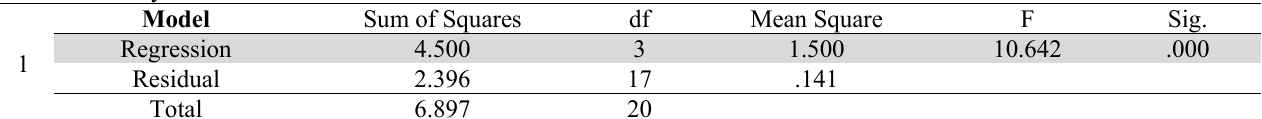
ANOVA Analysis – Model 2-ROE